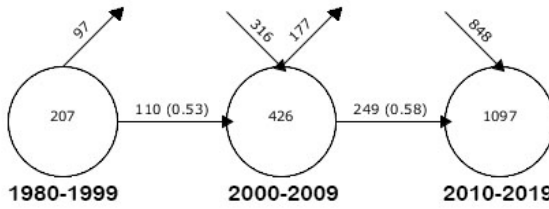
Figure 3. Overlapping map for the three analyzed periods (1980-1999, 2000-2009, 2010-2019). Source: